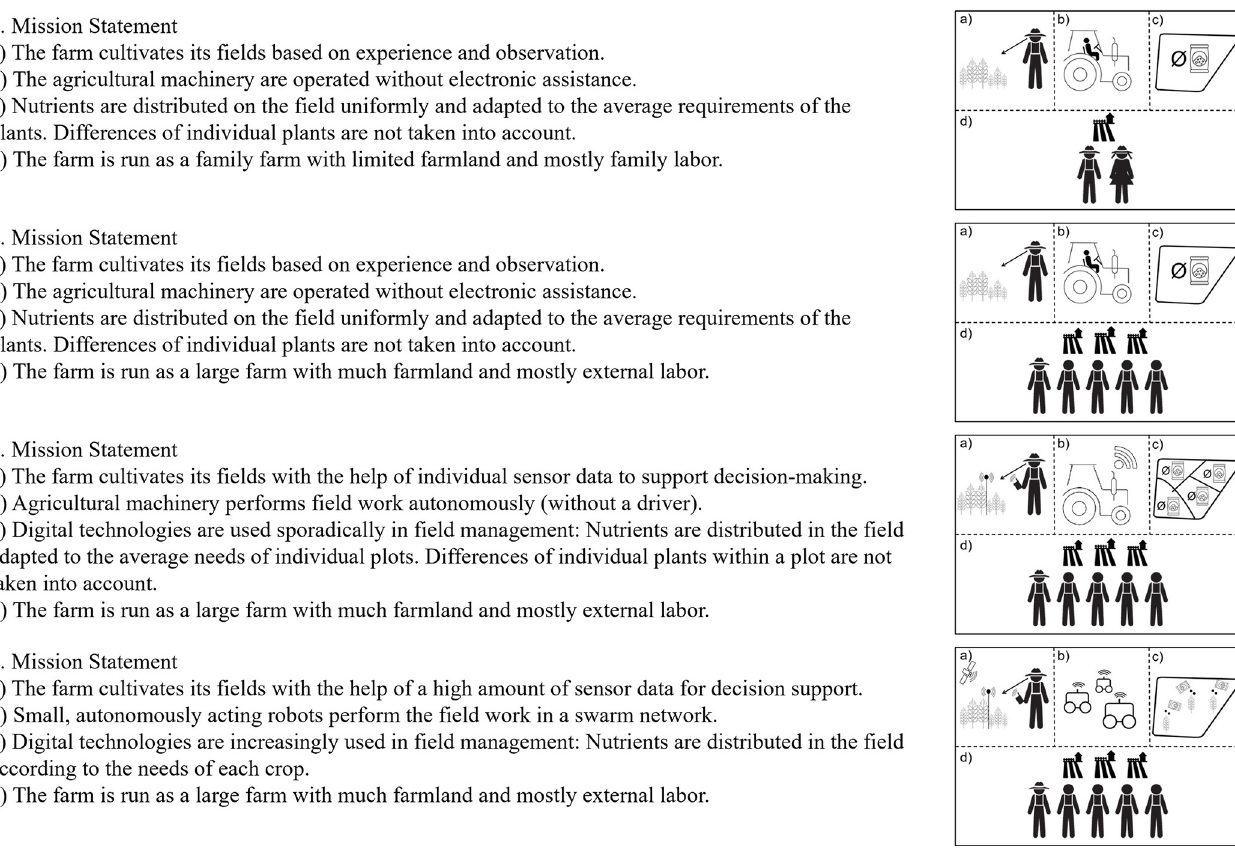
Fig 2. Mission statements with different farm sizes and altruistic arguments within